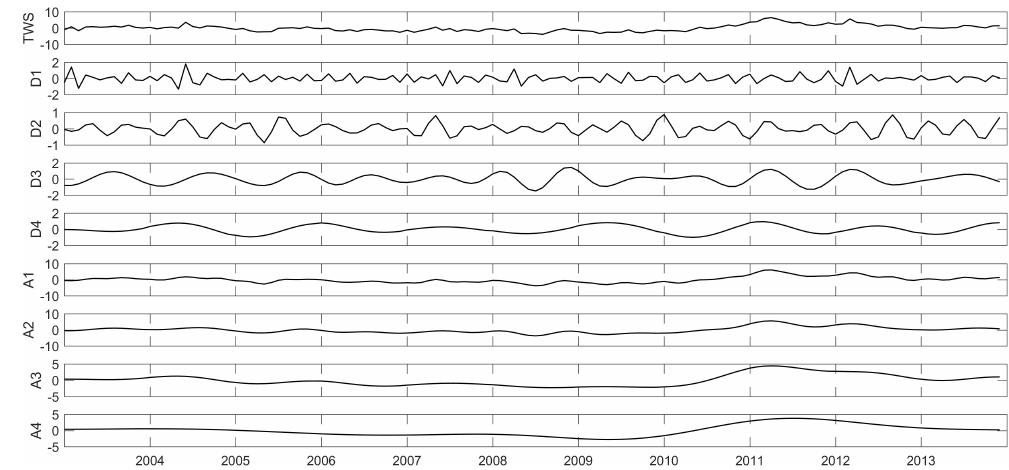
Figure 2. An example of a wavelet decomposition from a cell in central South Australia (29 ◦ S, 136 ◦ E). Note the visible trends in the approximations ( A 1– A 4), which are normalised in the details ( D 1– D 4).